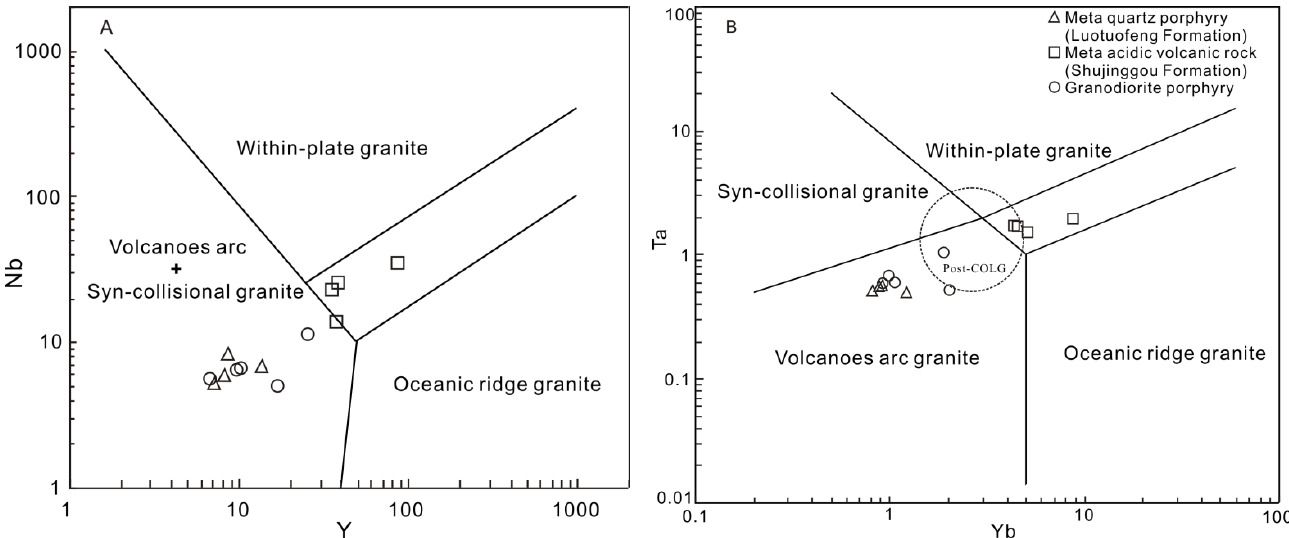
Figure 12. Y vs. Nb ( A ) and Yb vs. Ta ( B ) diagrams of Tongkuangyu granodiorite porphyry (after Pearce et al., 1984 [72]; regional rock data source as same as Figure